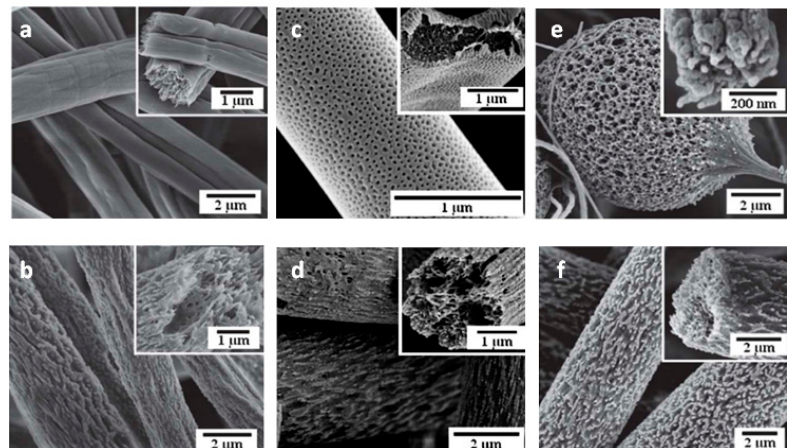
Figure 2. SEM images of electrospun polystyrene (PS) nanofibers produced at two molecular weights of ( a ) M w = 34 KD and ( b ) M w = 208 KD [13], morphology of PS nanofibers (M w = 208 KD) formed from tetrahydrofuran (THF) and dimethylformamide (DMF) solvents: ( c ) THF / DMF (100 / 0) ( d ) THF / DMF (40 / 60), PS ( M w = 208 KD) fibers nanofibers electrospun from ( e ) 10% and ( f ) 30% PS in THF:DMF (80 / 20 w / w ) [13] (Reproduced with permission from [13]. Copyright Elsevier, 2012).